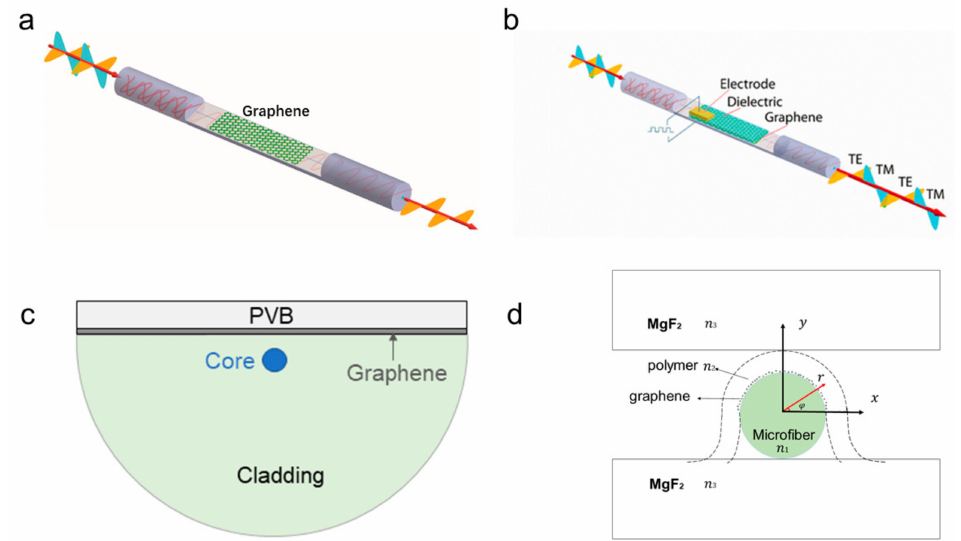
Figure 2. ( a ) Schematic illustration of the transverse electrical (TE)-pass polarizer. ( b ) TE-pass and transverse magnetic (TM)-pass switchable polarizers. ( c ) Cross-sectional view of polarizer structure, including Polyvinyl Butyral (PVB), graphene, and core. ( d ) Schematic of the cross section of the graphene-microfiber hybrid wave guide, in which polymer-supported graphene films cover the upper surface of the microfiber, sandwiched between two low-index substrates of the MgF 2 (RI, n 1 = 1.4443, n 2 = 1.367, n 3 = 1.37). Reproduced from [15] with permission of the American Chemical